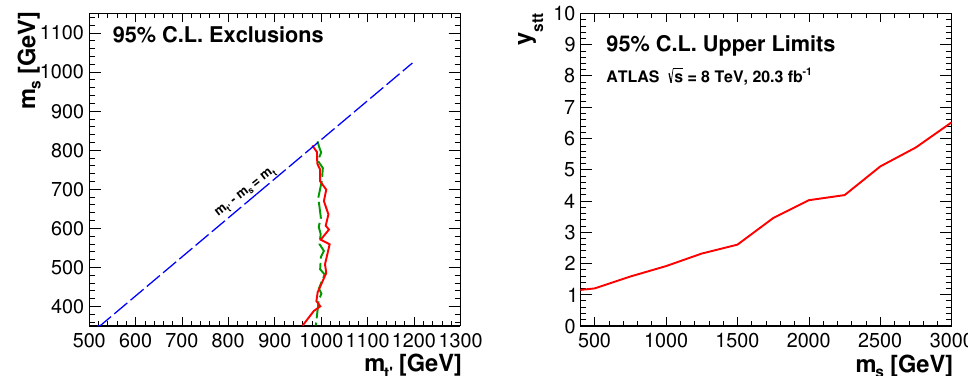
Figure 2 . Left: current constraints on the m s - m t 0 plane from the LHC as implemented in Check- MATE. The red line shows the boundary of the excluded region based on the analysis of ref. [36], and the green dashed line corresponds to ref. [37]. Right: upper limit on the s - t -(cid:22) t coupling strength as a function of m s from LHC searches for top pair production through scalar resonance [42]. states. A six top (cid:12)nal state also allows for the new, not previously analyzed,